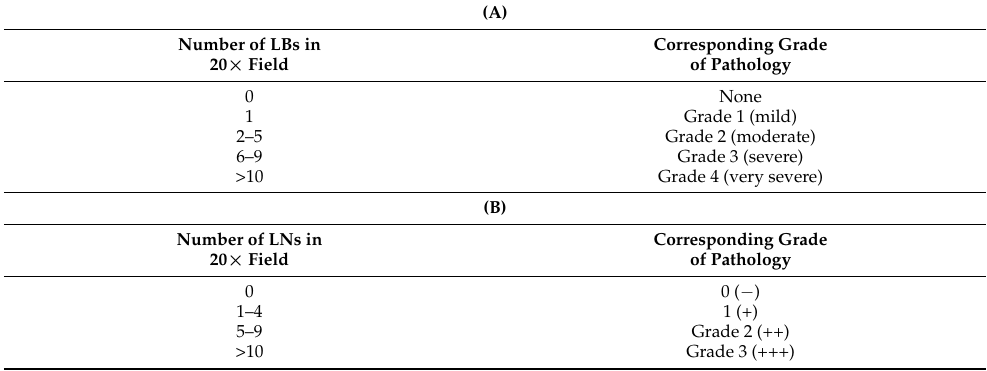
Table 3. ( A , B ) Lewy body and Lewy neurite grading applied in the